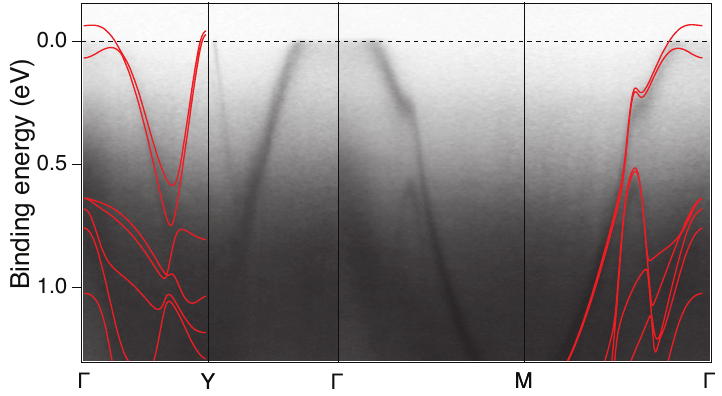
Figure 6: Excellent agreement between DFT (MBJ potential) and ARPES data . ARPES data along Γ − Y − Γ − M − Γ directions in k space, with the DFT bands overlaid in each case. The Fermi energy position in the DFT data has been shifted downward by 66 meV, compared to the original ab initio data shown in